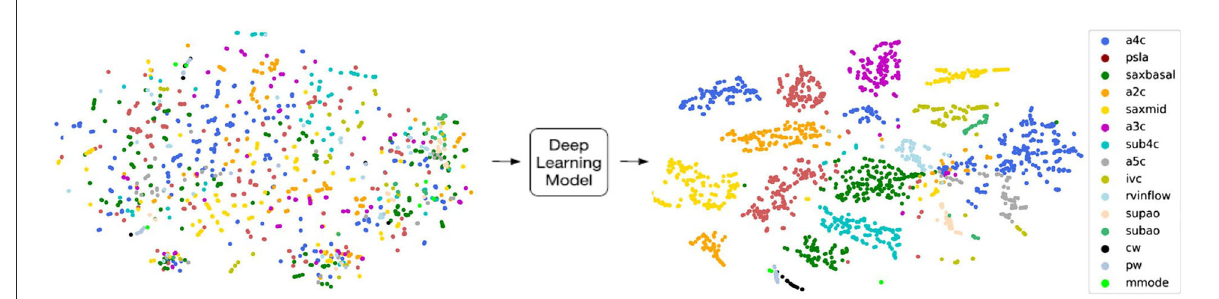
FIGURE4 T-distributed stochastic neighbor embedding (t-sne) is a deep learning-specific dimensionality reduction visualization tool that plots how similar each image is according to the deep learning model. Madani et al. developed a convolutional neural network (CNN) to classify echocardiographic images into 18 different views, and they used t-sne to understand how the CNN analyzed each image with respect to each other. Visually distinct views tended to group farther away from each other such as continuous wave Doppler (black; cw) and apical 4 chamber view (blue; a4c) while pulse wave (gray; pw) was very similar to continuous wave and tended to overlap. Figure adapted from Madani et al.